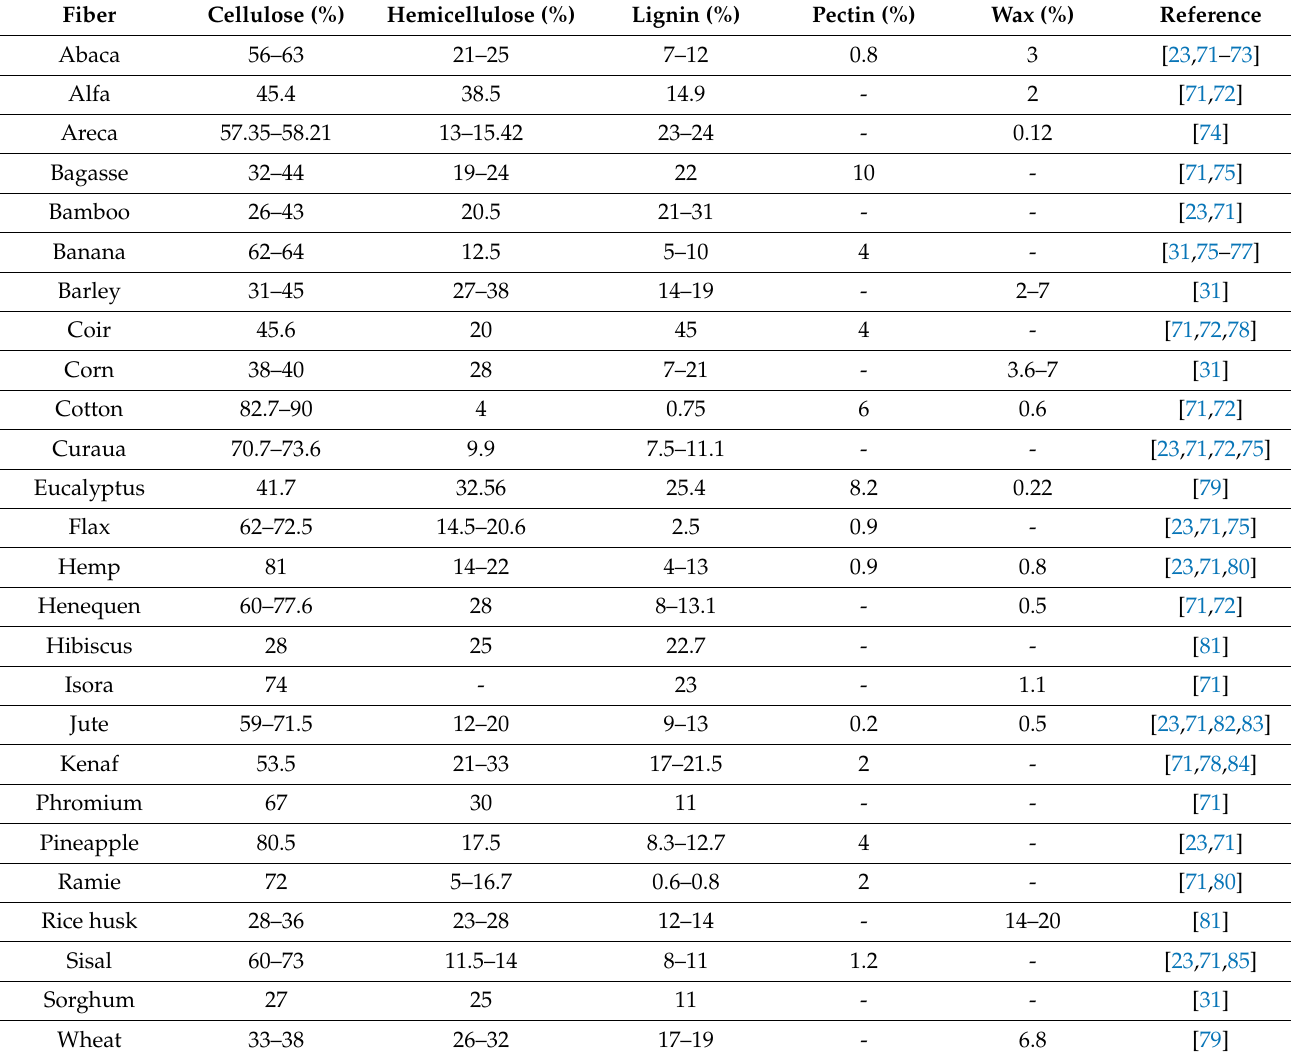
Table 1. Constituents of different natural